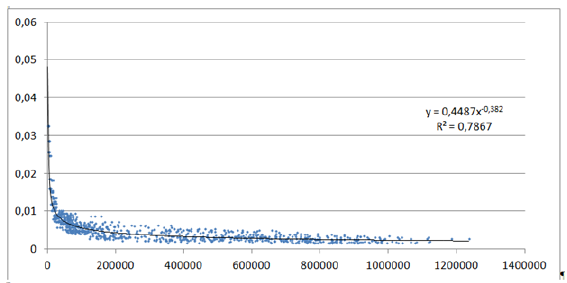
Figure. 5 Diagram of relations between reflectance intensity and accuracy of matching the reference plane (Markiewicz, Zawieska, 2015).